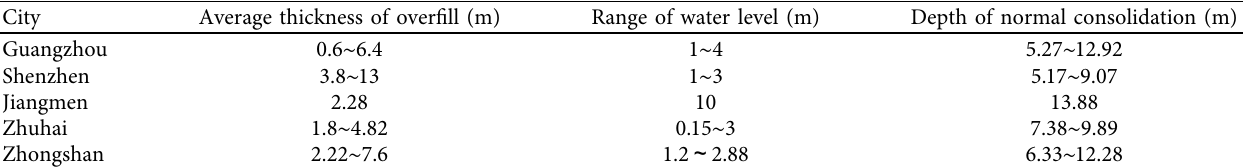
Table 3: Inverse calculation of normal consolidation depth of silt layer in each region. City Average thickness of overfill